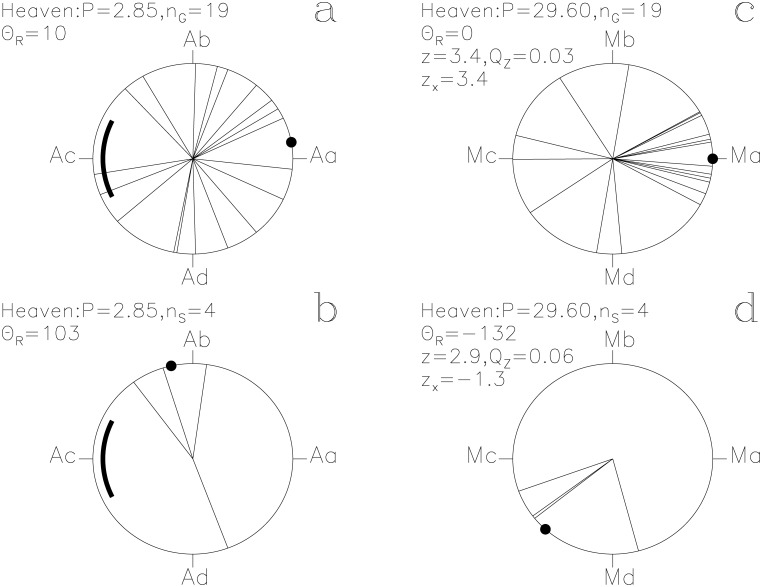
Heaven.otherwise as in Fig 1